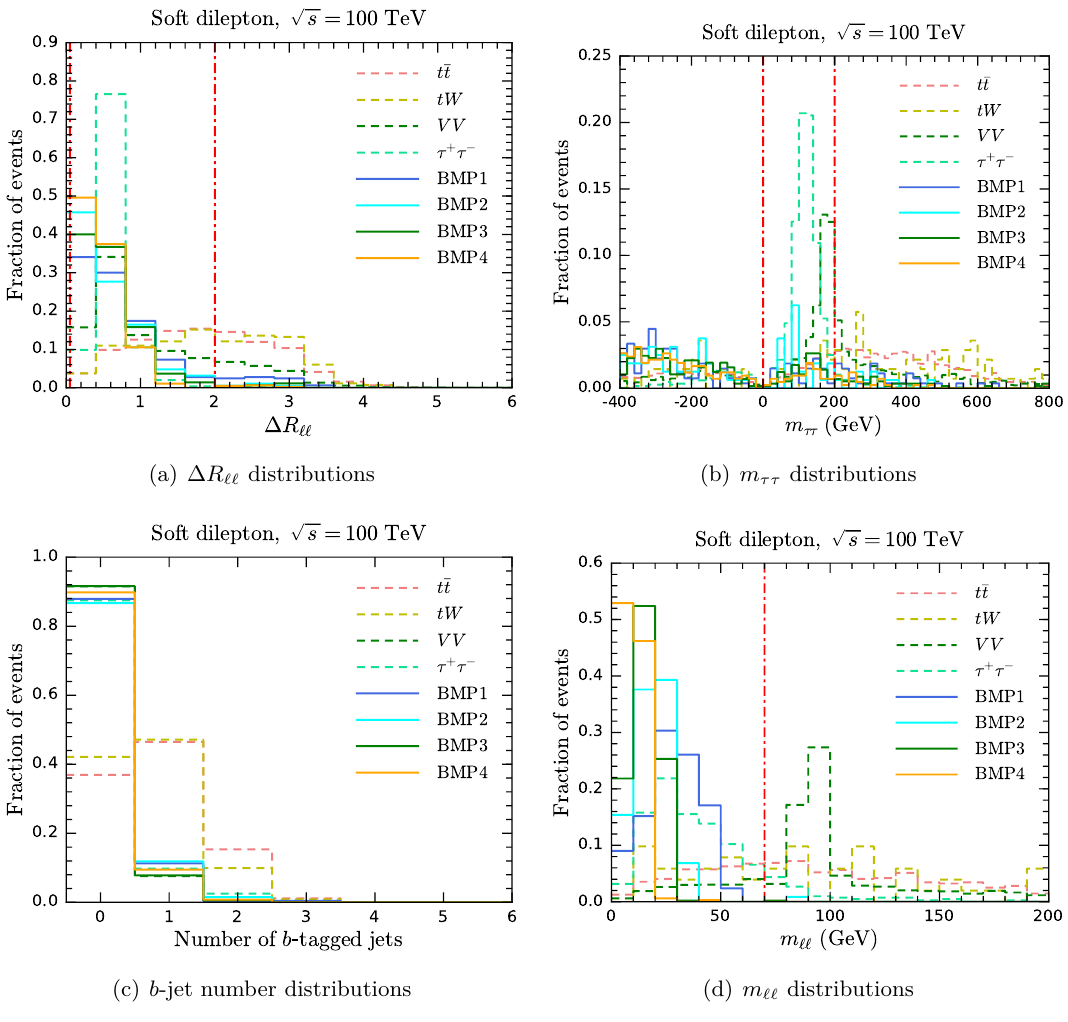
Figure 8 . Fractions of background and signal events binned in ∆ R ‘‘ after cut 1 (a), in m ττ after cut 2 (b), in the number of b -tagged jets after cut 3 (c), and in m ‘‘ after cut 4 (d) for the √ soft-dilepton + jets + /E channel at s = 100 TeV . The red dot-dashed lines indicate the cut T